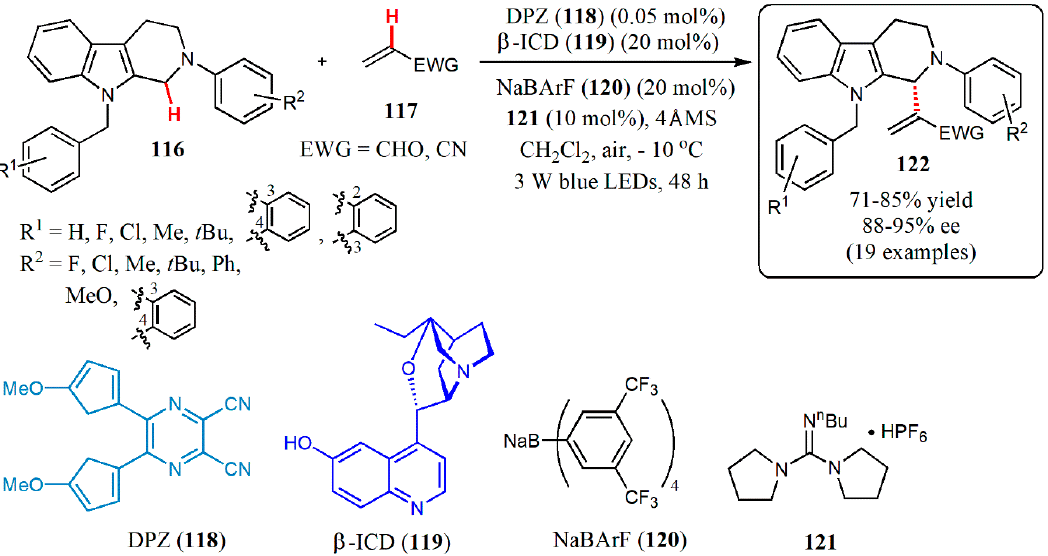
Figure 37. Enantioselective aerobic oxidative C(sp 3 )-H olefination of tetrahydro- β -carbolines via cooperative photoredox and asymmetric organocatalysis.